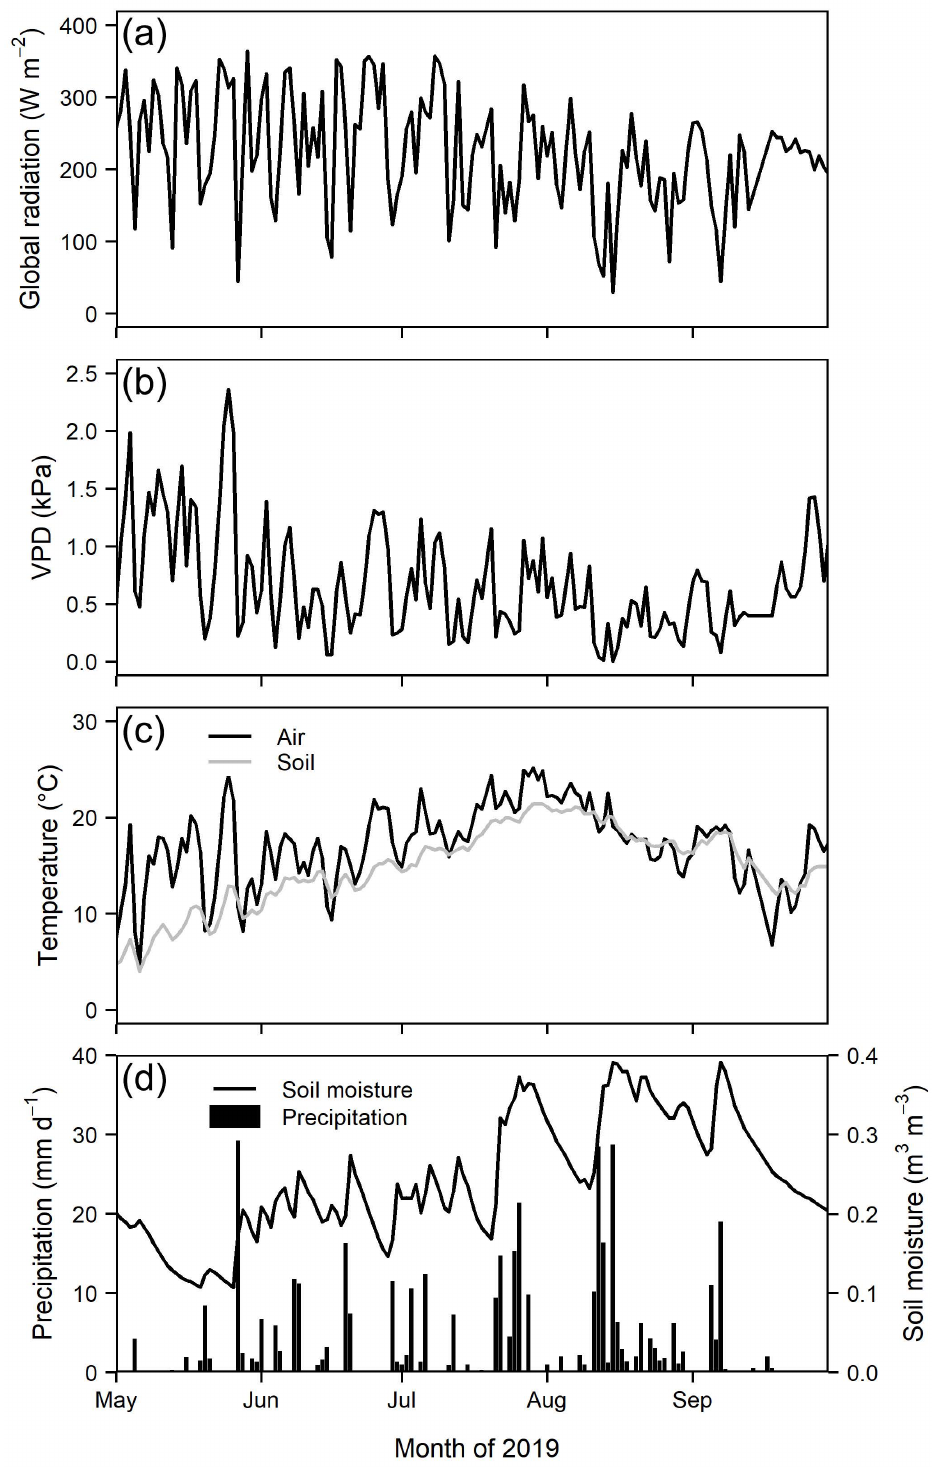
Figure 2. Seasonal variations in global radiation ( a ), vapor pressure deficit (VPD) ( b ), air and soil temperature( c ), andsoilmoistureandprecipitation( d )duringthe2019growingseason. Globalradiation, VPD, and air temperature are the averages of the seven heights in the forest. Soil temperature and soil moisture were measured at a 5 cm